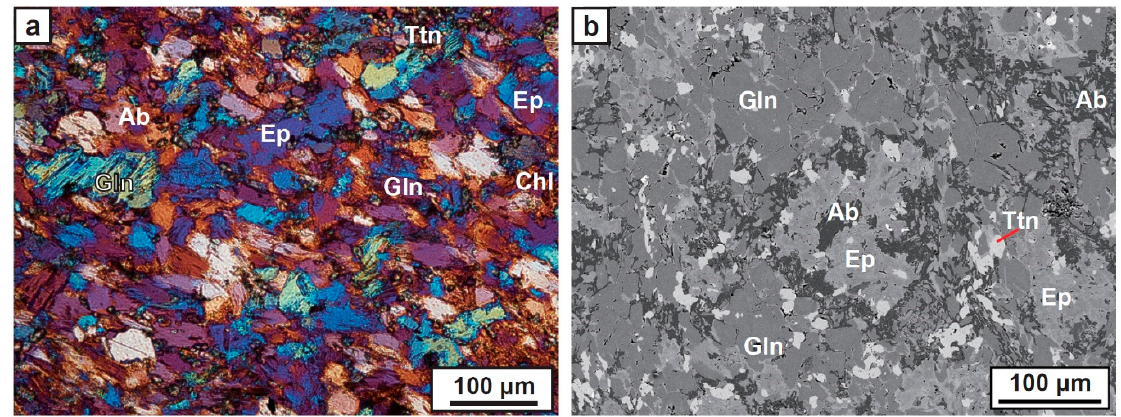
Figure 1. ( a ) Optical photomicrograph (XPL) with retardation plate ( λ = 530 nm) and ( b ) backscattered electron (BSE) image of the starting material (massive fine-grained epidote blueschist-facies rock). The average grain size of constituent minerals was ~30 μ m. Gln: glaucophane, Ep: epidote, Ttn: titanite,